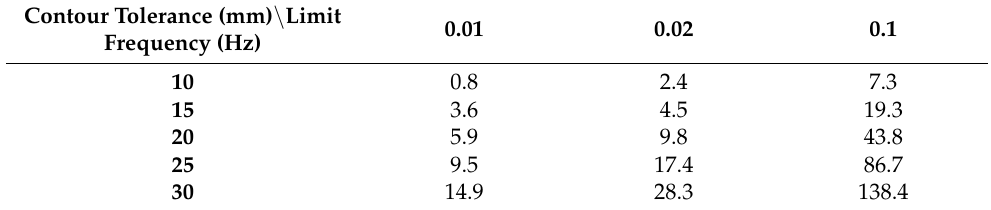
Table 3. Dependence of maximal contour error on corner jerk values. The presented corner jerk values (m/s 3 ) represent maximal values for which the contour tolerance was not exceeded for any of the tested angle sizes. The values were obtained by interpolation/extrapolation of the respective regression models formulated on the basis of “Fan” toolpath data and rounded to one decimal